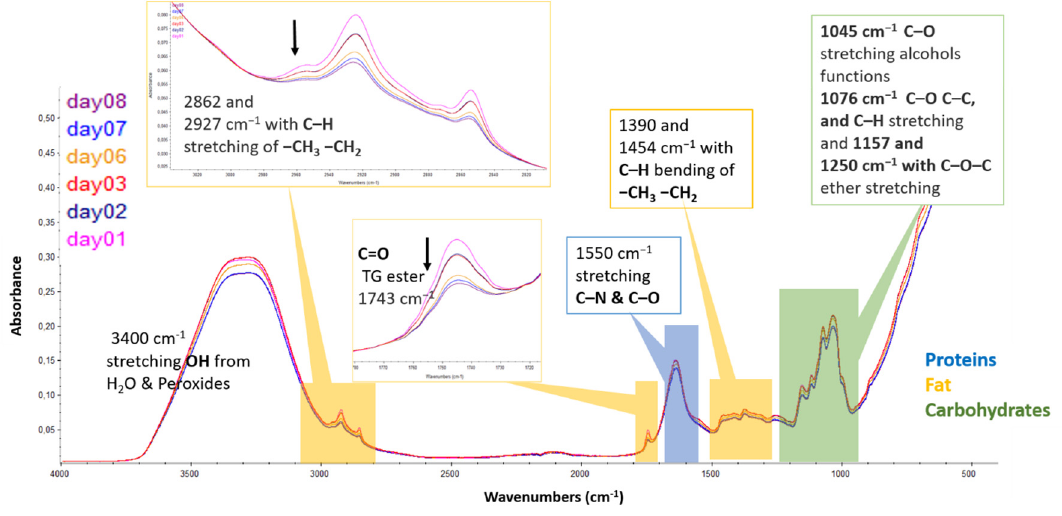
Figure 4. Variation of attenuated total reflectance Fourier-transform infrared (ATR-FTIR) spectra (4000–400 cm − 1 ) of liquid infant milk formula without antioxidants stored in dark at 70 °C for 8 days. Spectra are the average of three repetitions on three different subsamples. Standard normal variate (SNV) and baseline correction were applied on spectral data.